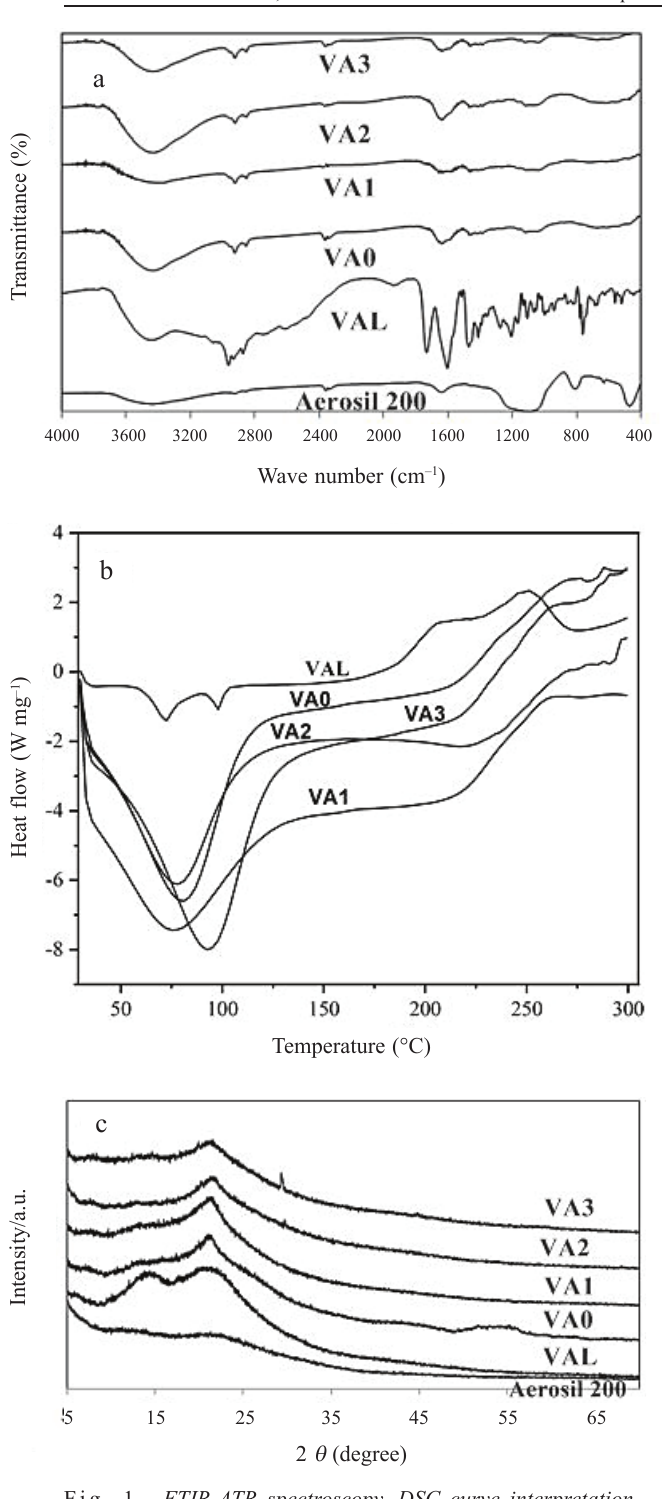
Fig. 1 – FTIR-ATR spectroscopy, DSC curve interpretation, X-ray diffraction of pure valsartan and film formula-